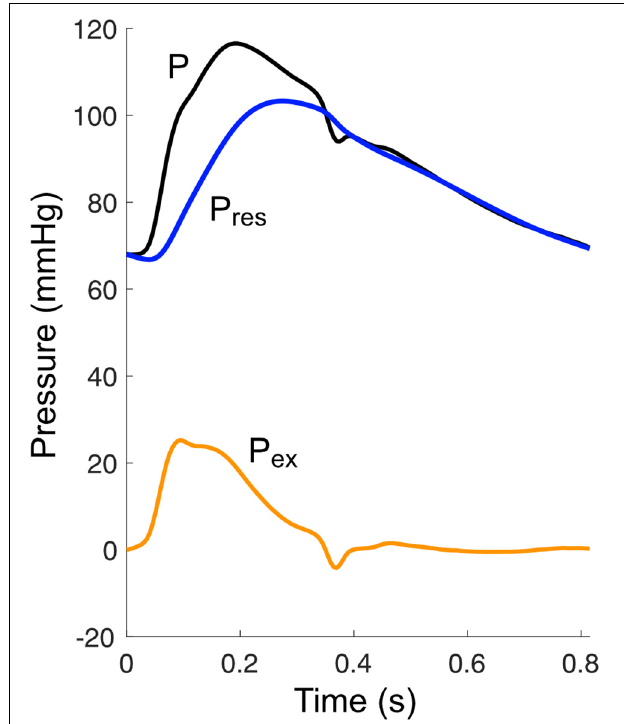
FIGURE 9 | Decomposition of pressure ( P ) into a reservoir pressure ( P res ) and an excess pressure ( P ex ).